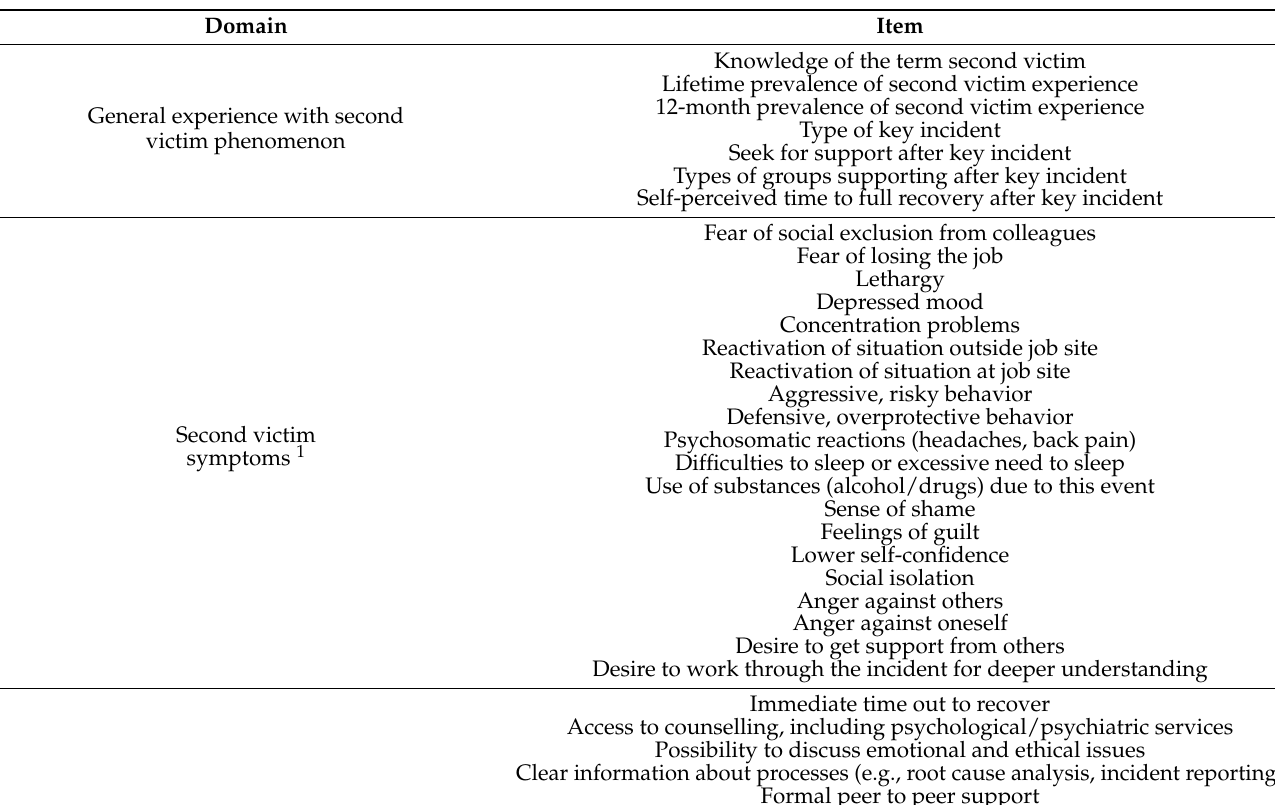
Table 1. Domains and items of the SeViD